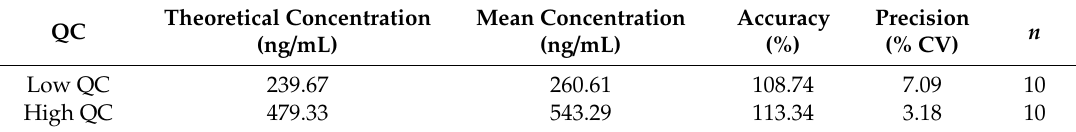
Table 1. Quality control result for acDrug (MMAF) in rat